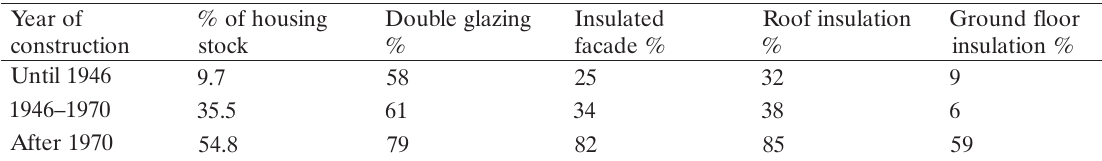
Table 2. Presence of insulation facilities in the Dutch social housing stock foraeY gnisuohfo% noitcurtsnoc kcots